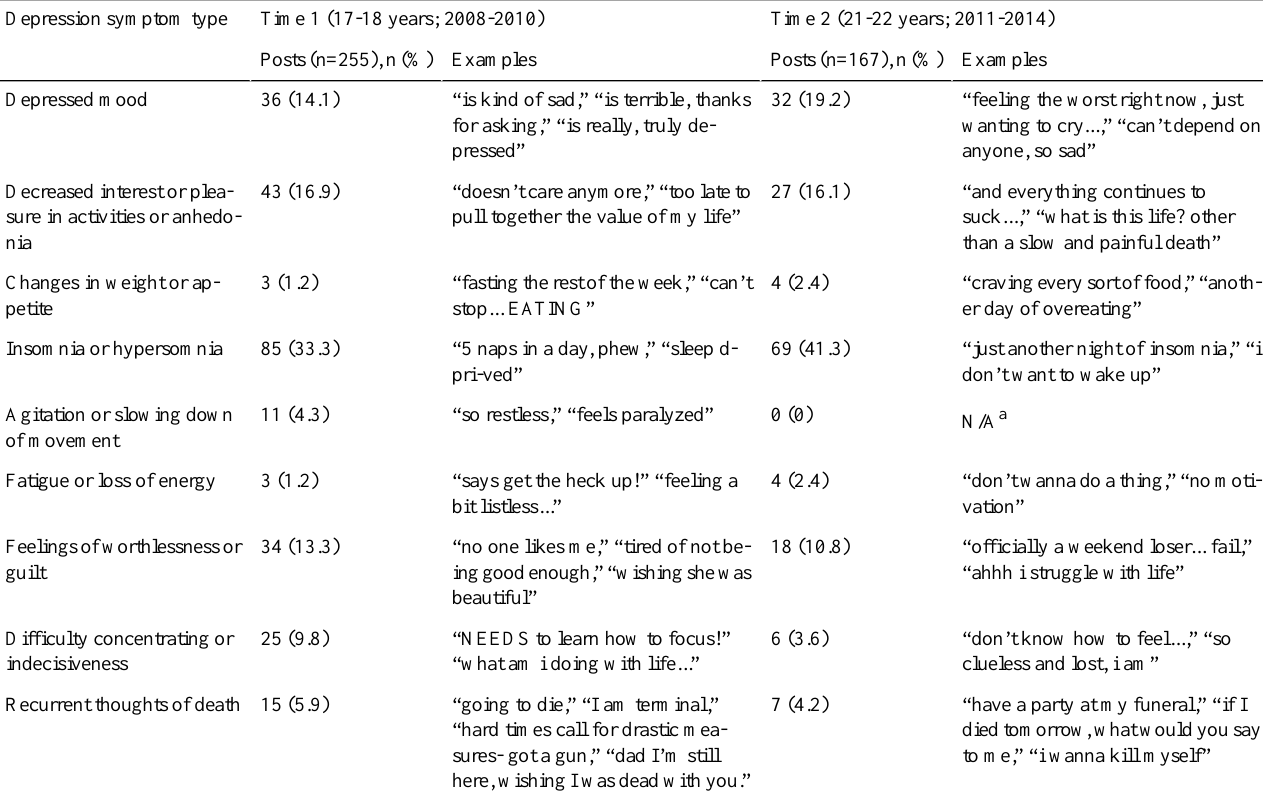
Table 2. Displayed depression symptom type on Facebook profiles by time